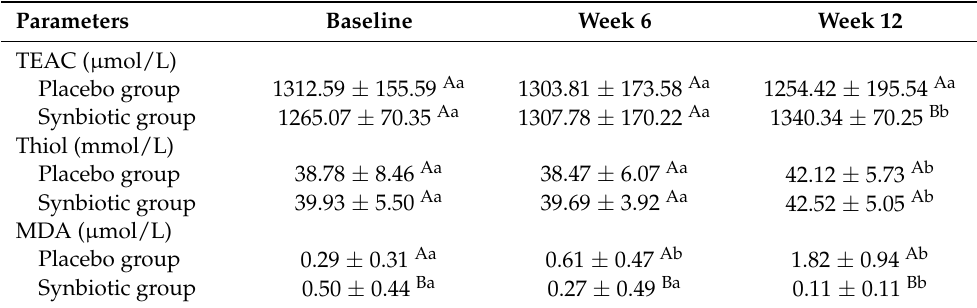
Table 4. Effect of 12-week synbiotic intervention on plasma antioxidant status in overweight and obese